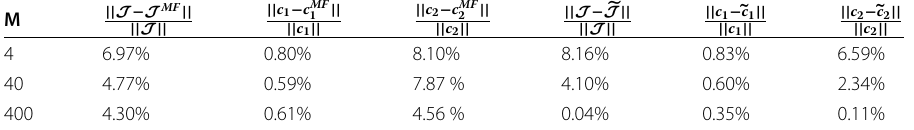
Table 1 Mean over the design variables ϑ of the “HF-to-MF” models relative error for the objective and constraints when the number of available HF simulations successively equals to 4, 40 and 400 points